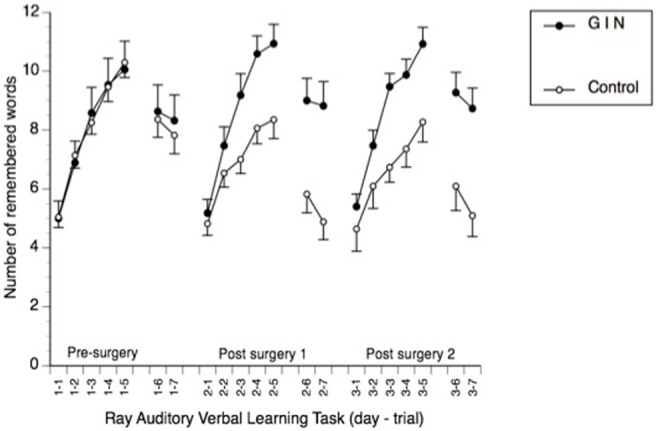
Performance of the subjects in the two groups over the course of the experiment.GIN: Experimental group with variable insulin infusion; Control: Best practice treatment; Pre-surgery: Neuropsychological assessment before surgery; Post surgery 1: Neuropsychological assessment approximately two months after surgery; Post surgery 2: Neuropsychological assessment approximately seven months after surgery; x-axis legend 1–1 to 3–7: days and iteration of verbal learning task.